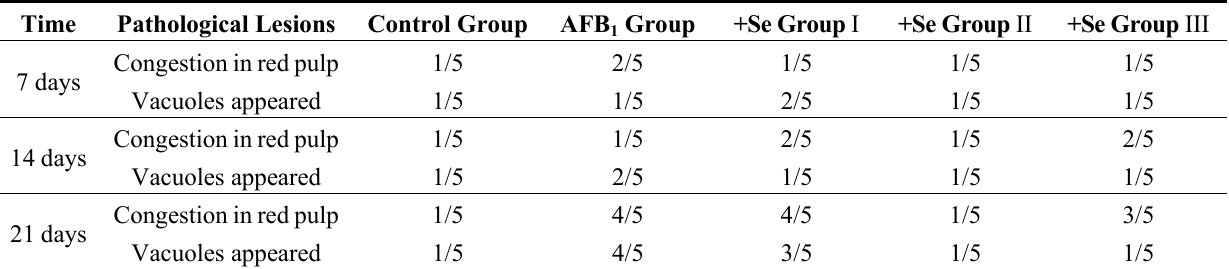
Table 2. Incidence of major spleen lesions.